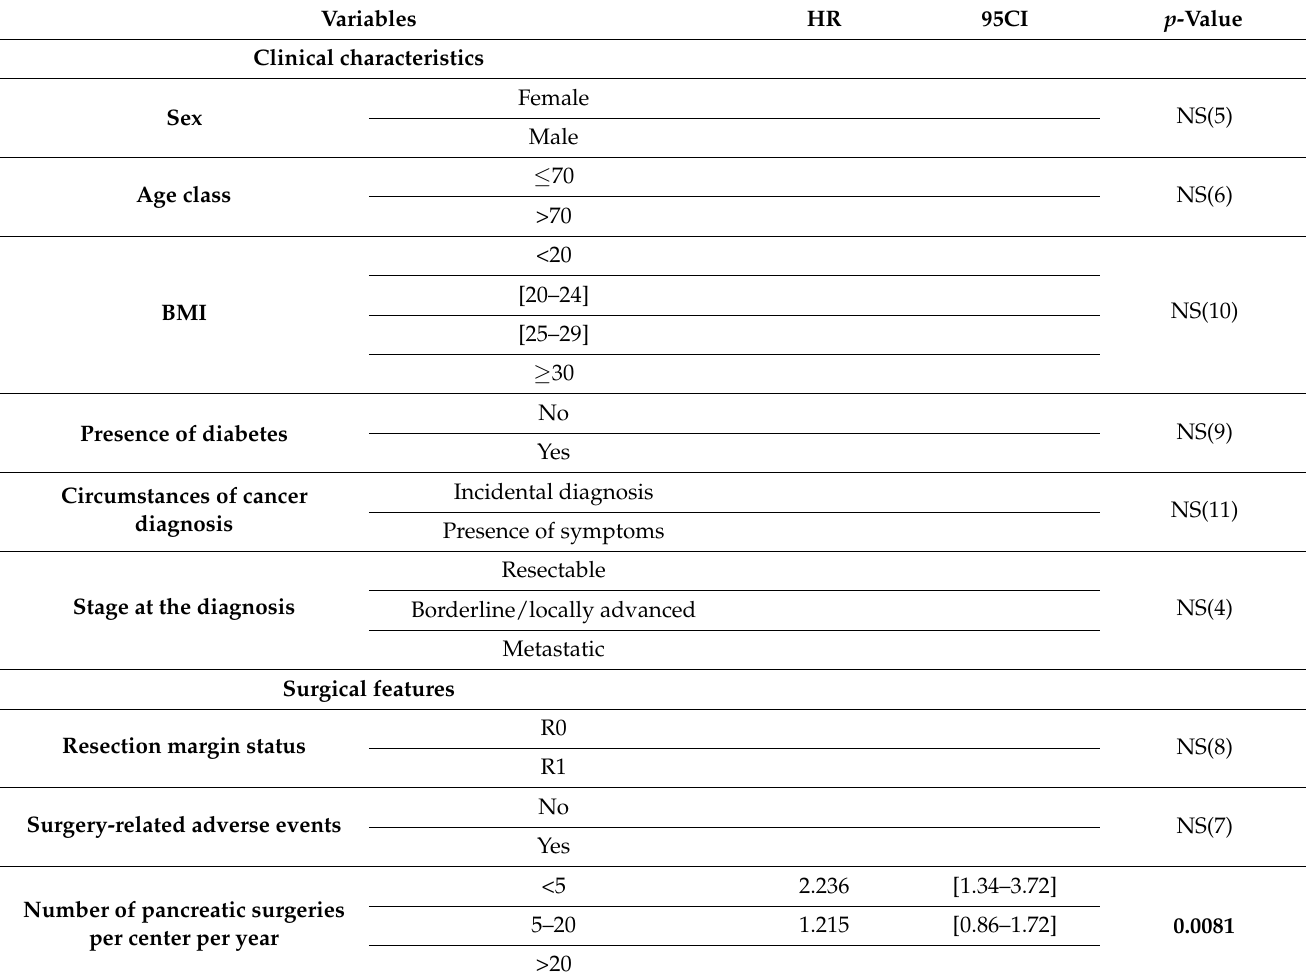
Table 3. Impact of clinical features and socio-spatial determinants on overall survival in resected patients after multivariate analyses. The final model included 177 patients. The number presented between parentheses in the p -value column corresponds to the rank of the variable (rank) in the multivariate analysis based on its p -value. p -values < 0.05 are marked in bold characters. Variables HR 95CI p